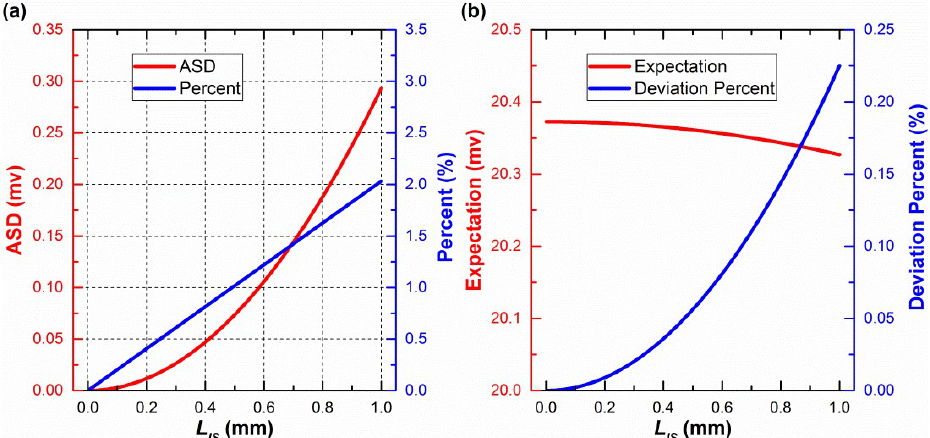
Figure 11. After using the central-symmetry method: ( a ) The influence of L IS on ASD and percent; ( b ) the influence of L IS on expectation and deviation percent.